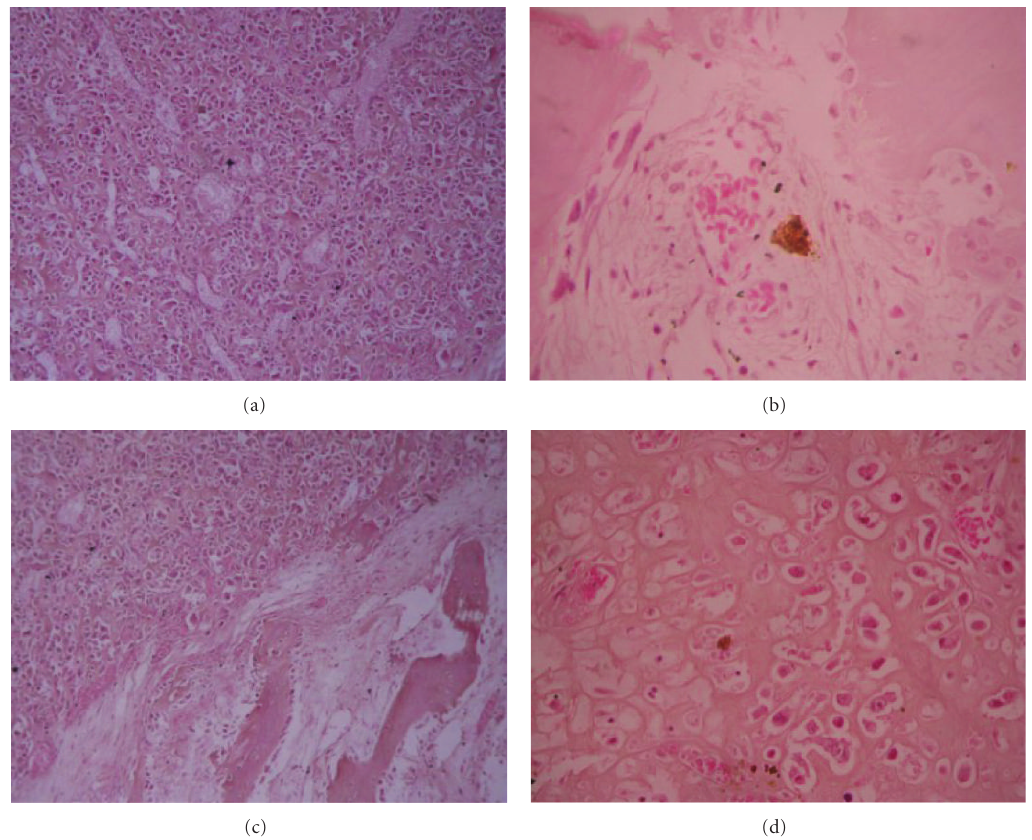
Figure 3: (a) Osteoblastic variant of osteogenic sarcoma of case 1 showing osteoblasts with cytonuclear pleomorphism and hyperchromatic nuclei surrounding malignant osteoid (X100). (b) Cemento-osseous dysplasia showing a benign mesenchymal neoplasm composed of irregular islands of immature bone with osteoblastic rimming surrounded by a moderately dense fibrous connective tissue stroma (X100). (c) A possible transition zone between osteogenic sarcoma and cemento-osseous dysplasia (X400). (d) Chondroblastic osteosarcoma of case 2 showing a malignant mesenchymal neoplasm consisting of pleomorphic chondroblast with prominent hyperchromatic nuclei amidst malignant osteoid(X100).